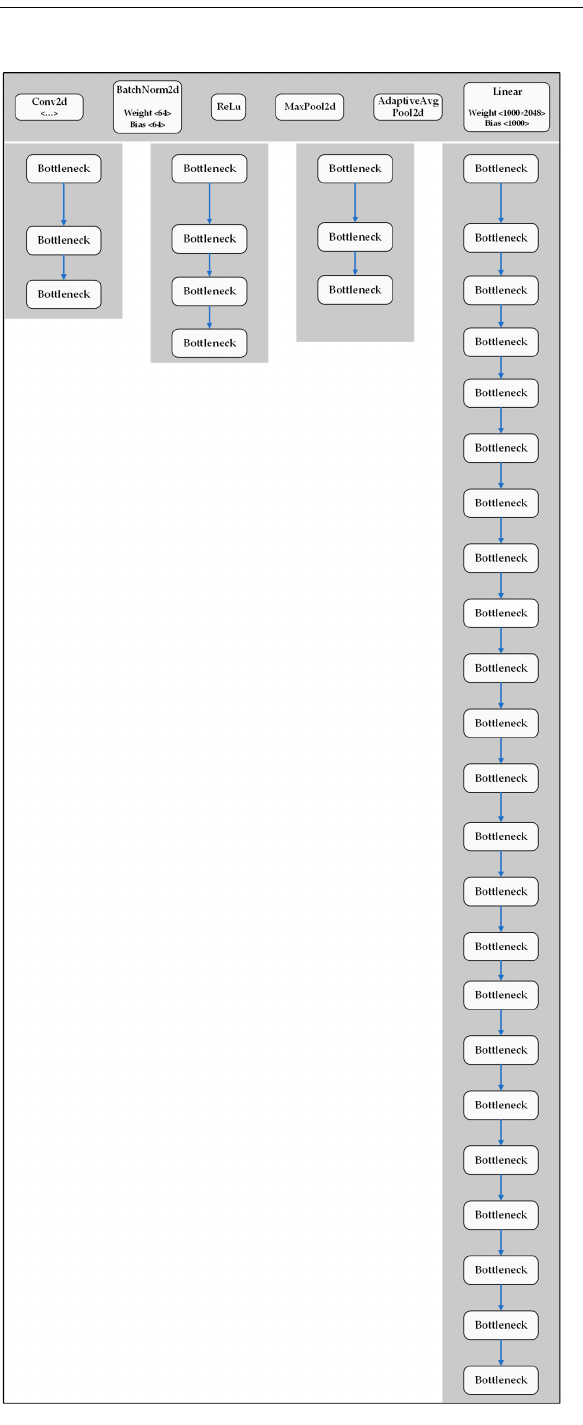
Figure 12. Structure of ResNet-101 model.